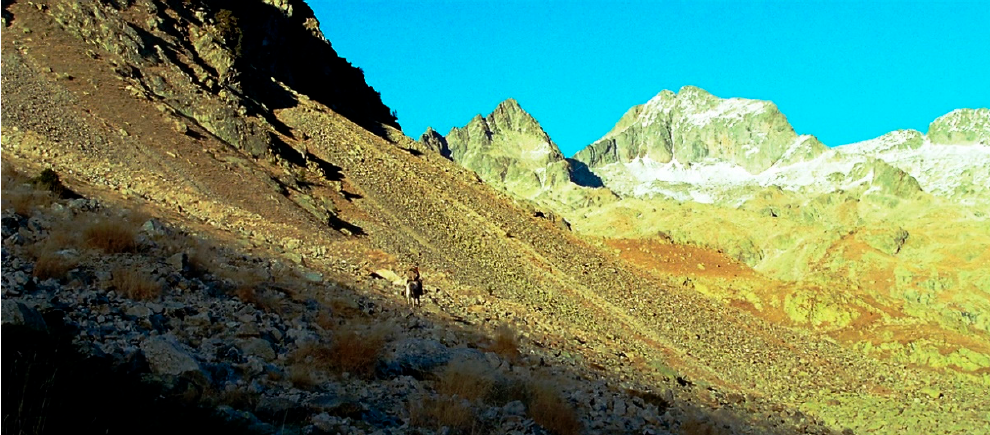
Figure 1. Land degradation on the cold and arid Qinghai–Tibet Plateau has accelerated in response to rising pressure from increasing populations of people (inward migration, natural increase) and of livestock (photo: H.Y.